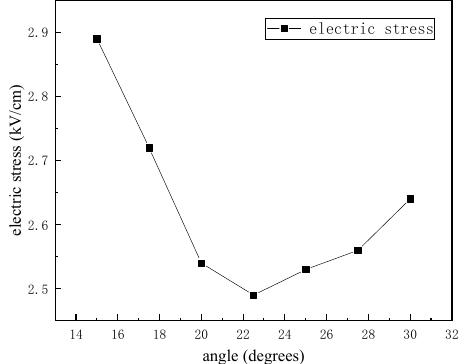
Figure 11. Maximum electric stress at various angles.